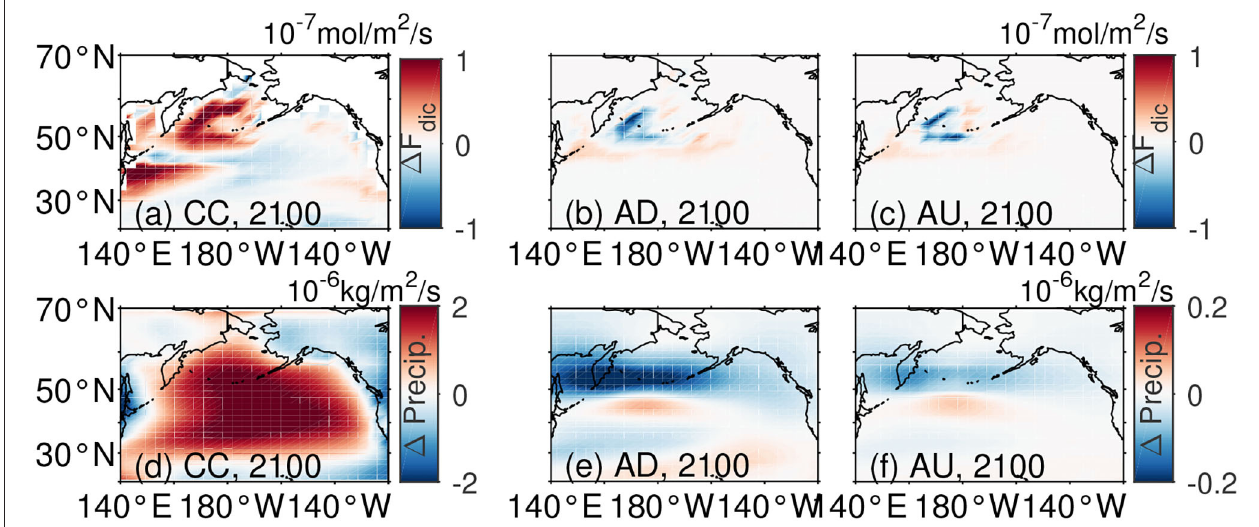
FIGURE 8 | Field anomalies of (a–c) dissolved inorganic carbon flux and (d–f) precipitation flux in the year 2100 with respect to 2020, caused by climate change (CC, left), artificial downwelling (AD, middle), and artificial upwelling (AU,